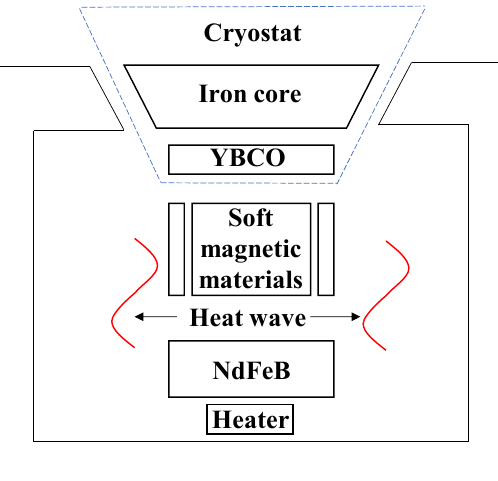
Figure 15. Illustration of the experimental set up for a thermal actuated HTS flux pump. Adapted from [48].